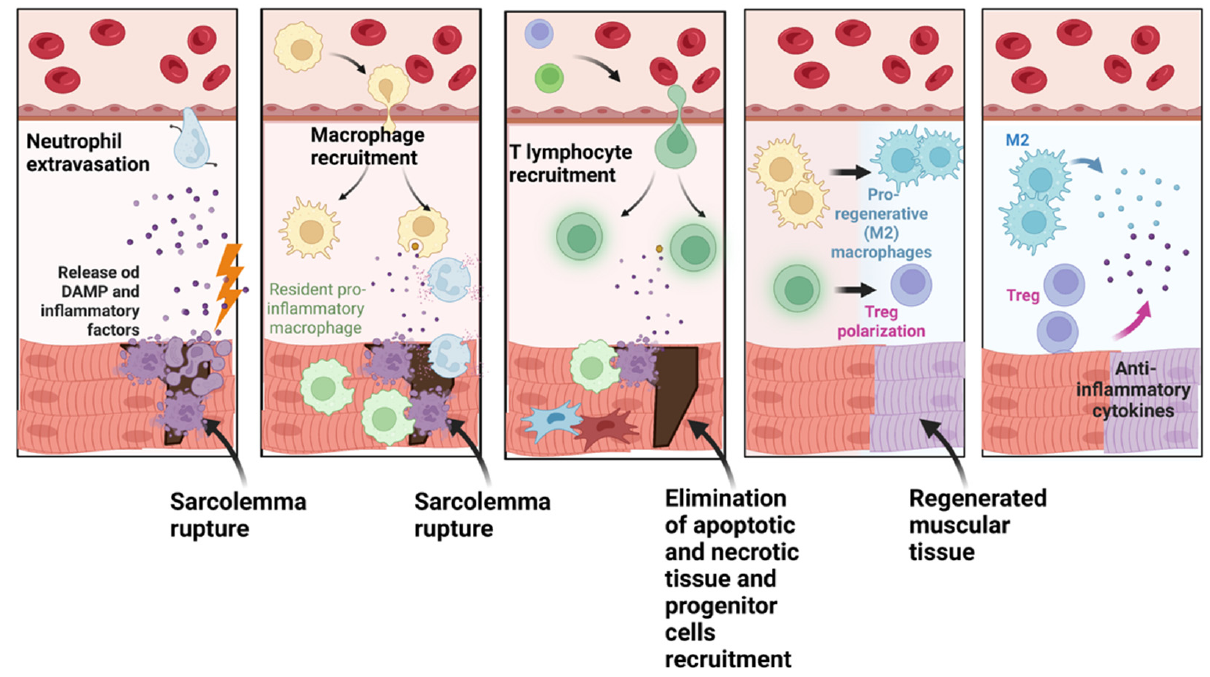
Figure 1. The evolution of the inflammatory response in muscle damage. When muscle tissue is damaged, the release of inflammatory factors and damage-associated molecular patterns (DAMPs) occurs, which attract various cells of the immune system. The first to intervene are the neutrophils, which extravasate to the site of injury. Here, in the case of sterile inflammation, i.e., in the absence of bacteria or other pathogens, they will start to perform a cleansing action against the apoptotic or damaged cells. In addition, they will produce reactive oxygen species (ROS), which will in turn be responsible for recruiting other types of immune cells. The inflammatory state induced by the damage also leads to the involvement of resident macrophages in the first instance, while others will be attracted by the chemotactic factors released by both the damaged muscle cells and neutrophils. Once the cleansing action of the apoptotic and necrotic cells is complete, the recall of T lymphocytes and muscle progenitors occurs. The latter, stimulated by the cascade of inflammatory signals, will be stimulated to repair the damage with the restoration of functional homeostasis. The repair process concludes with the polarization of T lymphocytes and macrophages towards immunoregulatory subsets (treg and M2 macrophages), which, through the release of cytokines and other factors, will modulate the immune response until the inflammatory status ceases. (Figure designed using Biorender.com, 07 ‐ 11 ‐ 2022).